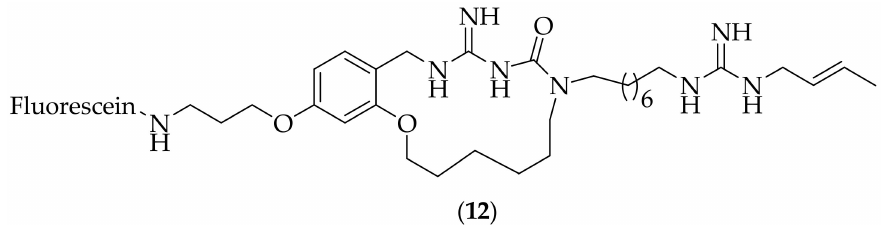
Figure 7. Fluorescent probe derivative ( 12 ) based on a cyclized analog of guazatine.